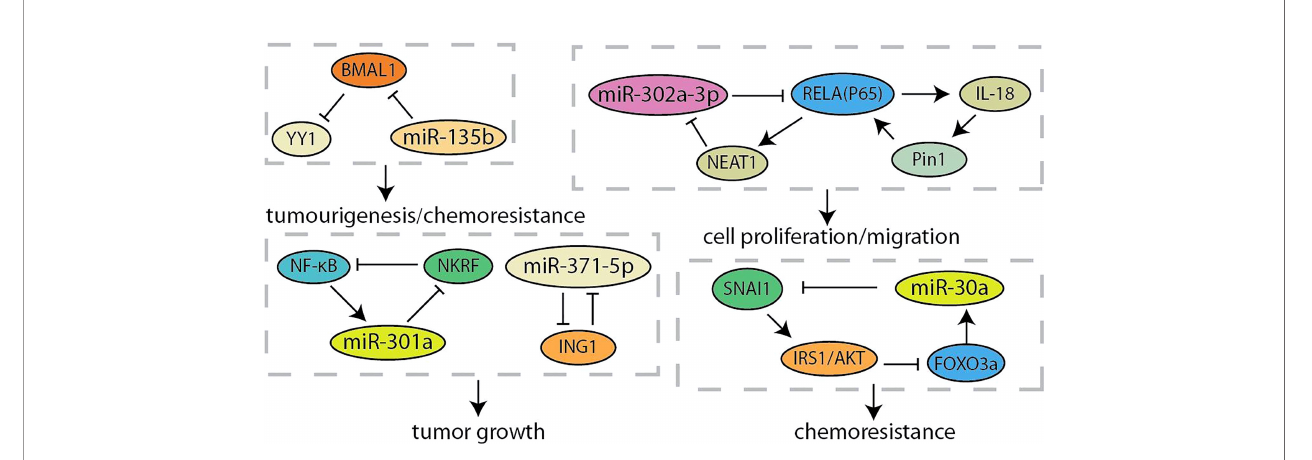
FIGURE 4 | Summary of microRNA related feedback loops in pancreatic cancer.